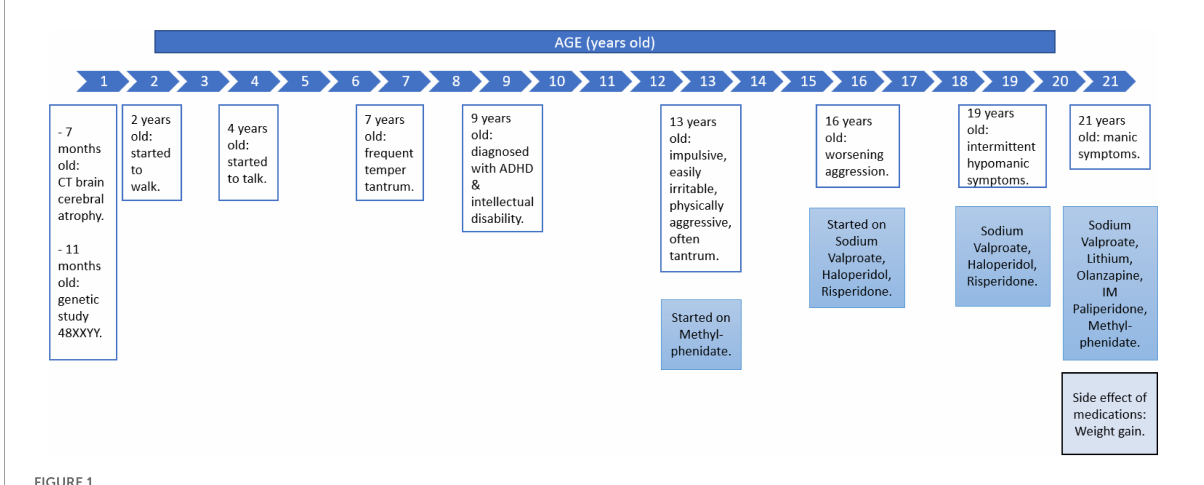
FIGURE1 Timeline of the patient’s progress and